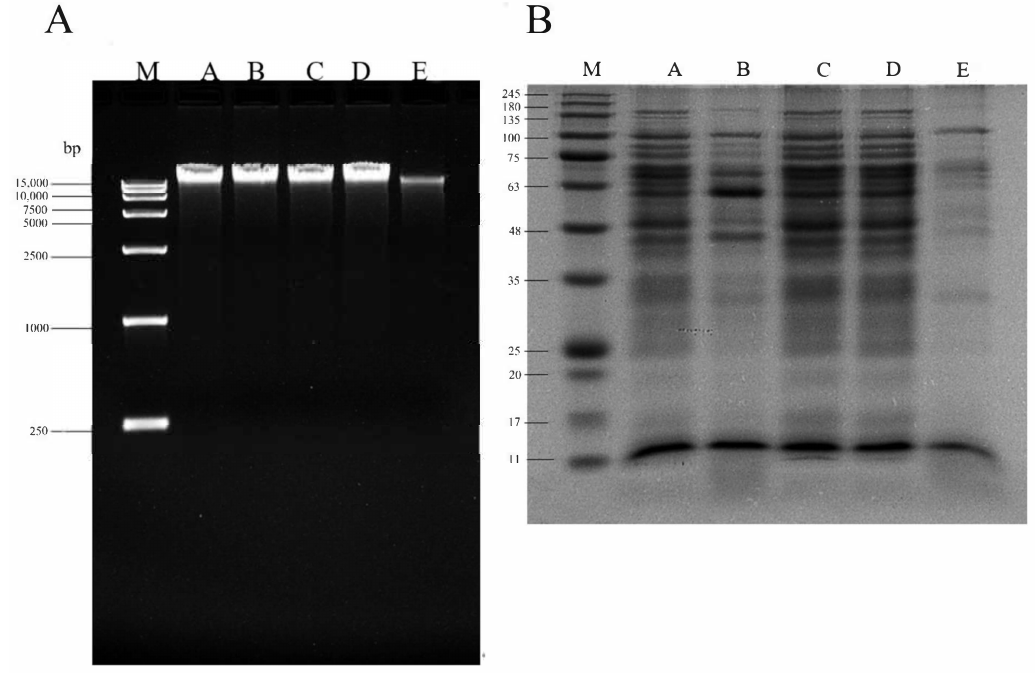
Figure 6. Curcumin-mediated sono-photodynamic treatment induced genomic DNA cleavage and general degradation of bacterial proteins in Listeria monocytogenes . ( A ) Agarose gel electrophore- sis analysis of the cleavage of Listeria monocytogenes genomic DNA samples. ( B ) SDS-PAGE pro- file of Listeria monocytogenes total proteins. M: Marker; lane A: Control group without treatment; B: Curcumin-treated group; C: Light-illuminated group; D: Ultrasound-treated group; E: Curcumin- mediated sono-photodynamic treated